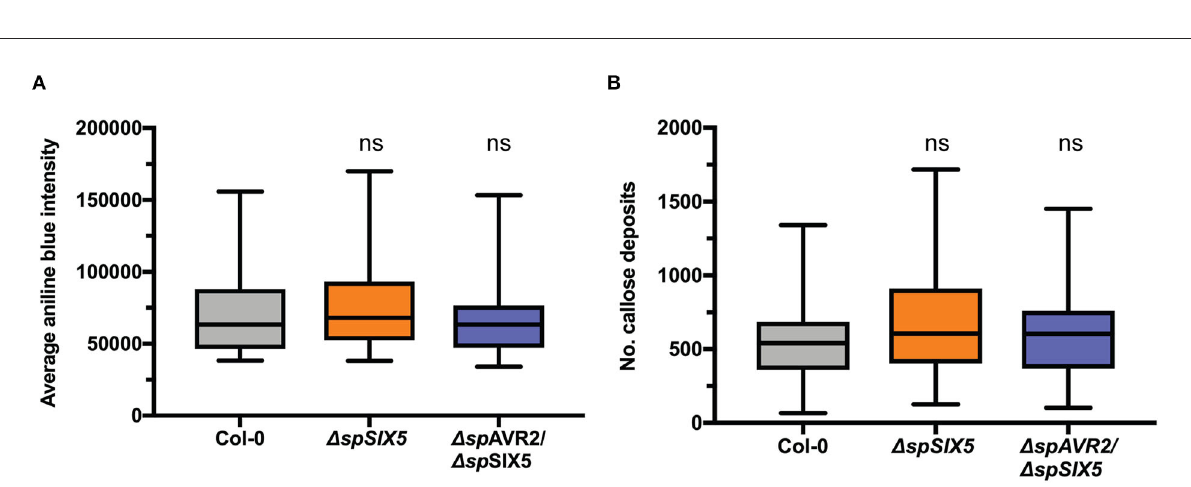
FIGURE5 The effector pair Avr2/Six5 does not affect callose deposition at plasmodesmata. (A) PD-localized callose depositions in wild-type, 1 spSIX5, or 1 spAVR2/ 1 spSIX5A. thaliana Col-0 leaves. Callose depositions were stained with aniline blue and visualized using confocal microscopy, determining the integrated density of callose deposits per z-stack. About 7–8 biological replicates were performed, of which the average is depicted (one-way ANOVA; Dunnett’s multiple comparison test). (B) Number of PD detected per z-stack. About 7-8 biological replicates were performed, of which the average is depicted (one-way ANOVA; Dunnett’s multiple comparison test, ns: p > 0.05). Boxes extend from the 25th to the 75th percentile, whiskers from lowest to highest values, and the bar indicates the